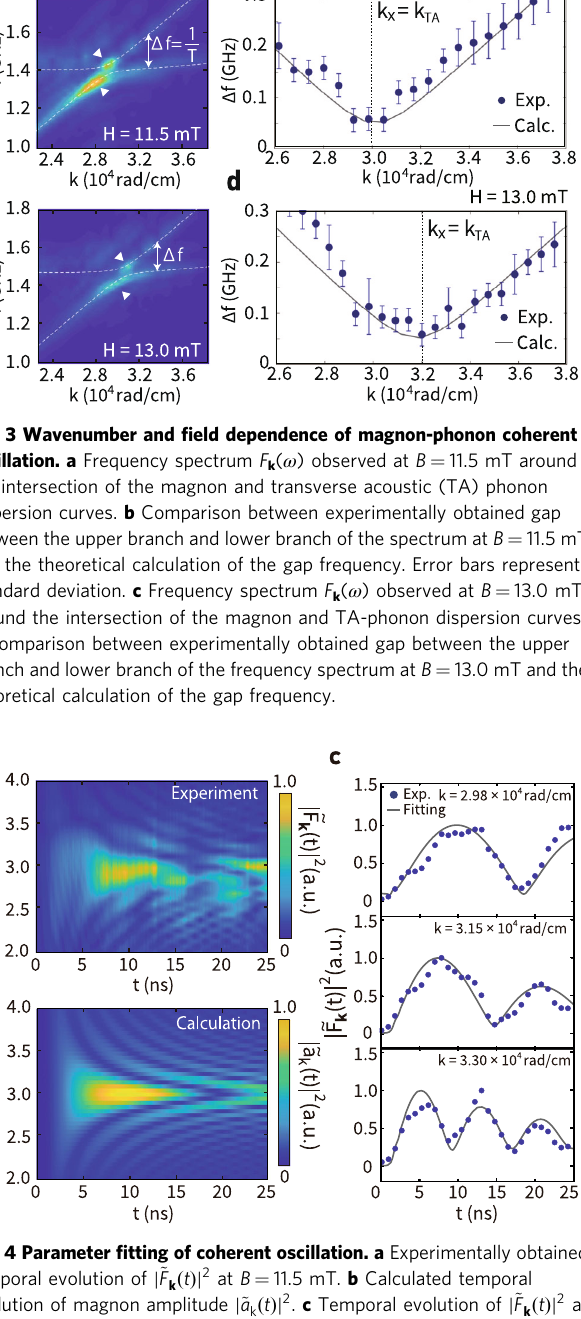
Table 1 Coupling constant σ k , relaxation constant of